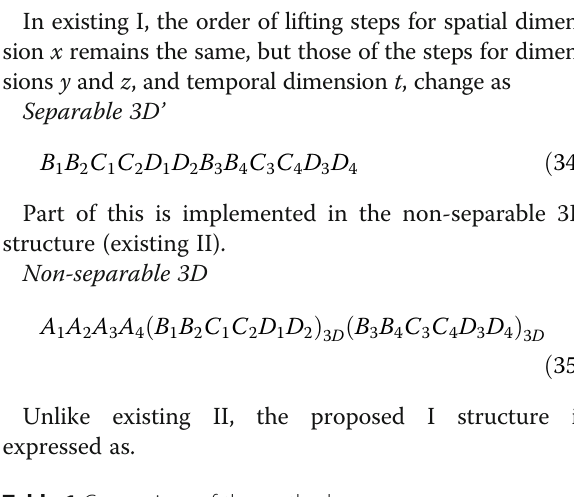
Table 1 Comparison of the methods Structure Lifting steps Rounding